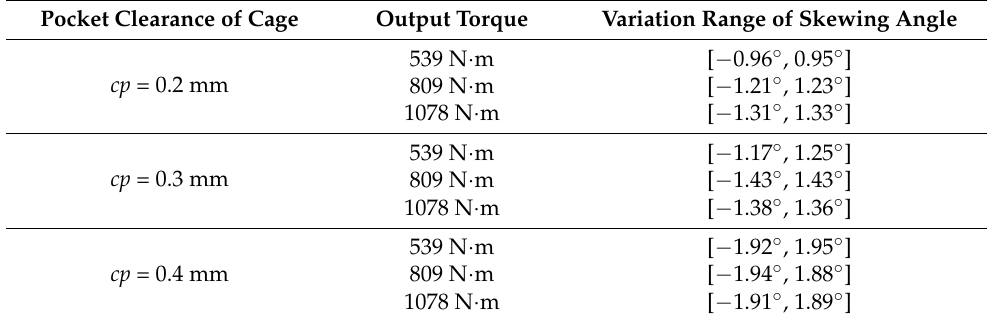
Table 3. The variation range of skewing